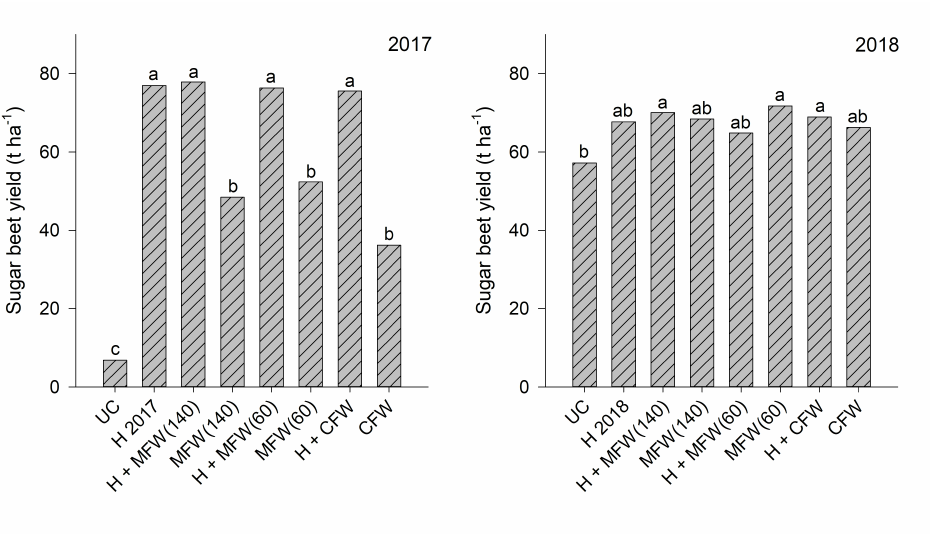
Figure 5. The bars represent the mean sugar beet yield (tha − 1 ) recorded for each treatment in 2017 and 2018. Different letters above a bar and within the same graph (2017 or 2018) indicate significant differences between the treatments according to the Tukey HSD-Test at α ≤ 0.05. UC: Untreated Control, H: Herbicide spraying, MFW (140): Motorized finger weeder fast speed, MFW (60): Motorized finger weeder slow speed, and CFW: Conventional finger